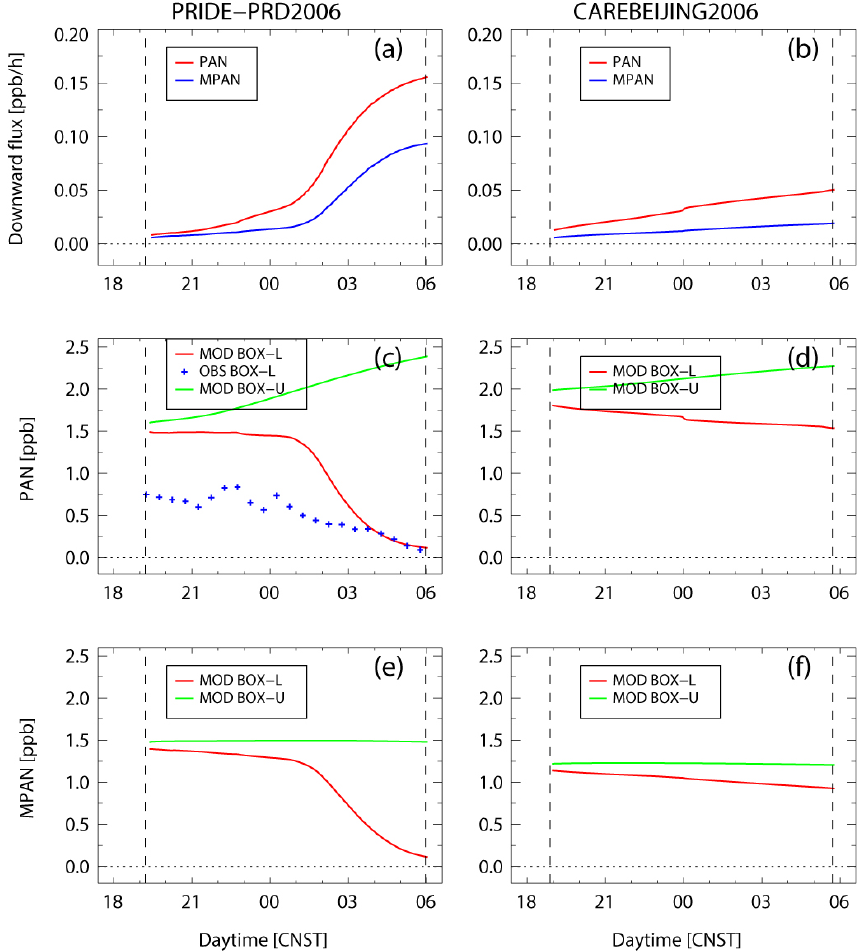
Figure 12. Estimated fluxes of PAN and MPAN transported downward from the residual layer to the stable surface layer during PRIDE- PRD2006 (a) and CAREBEIJING2006 (b) . In the lower layer, the transported compounds decompose thermally and produce peroxy radicals at a rate approximately equal to the downward fluxes. The observed (if available) and modeled PAN and MPAN concentrations are shown in (c) – (f)